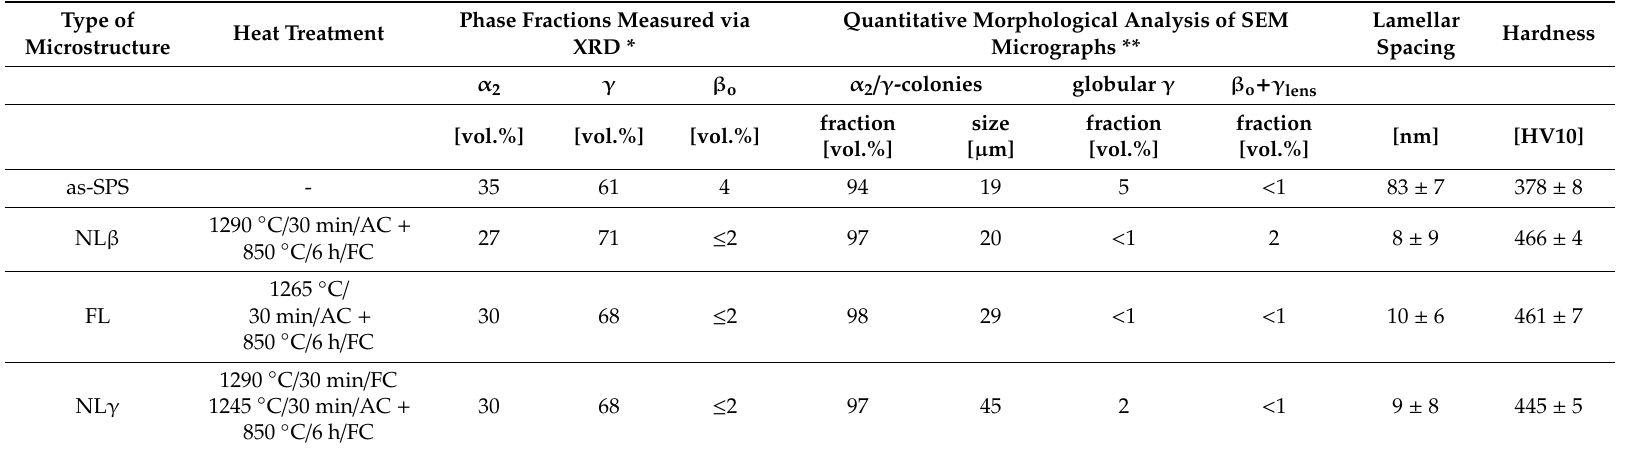
Table 2. Microstructural state in as-SPS and heat-treated condition (see